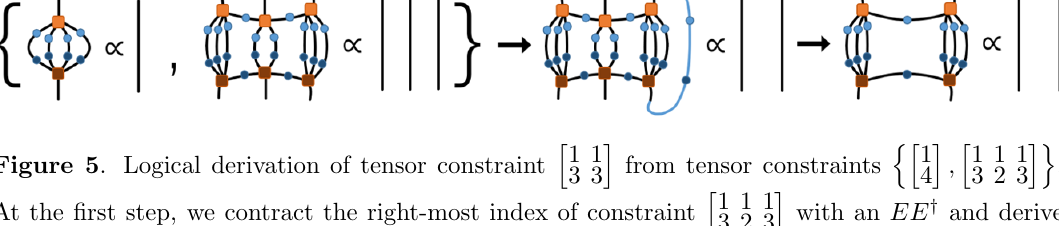
h 1 1 0 i . At the second step, we reduce constraint 3 2 4 h 1 1 i . 3 3